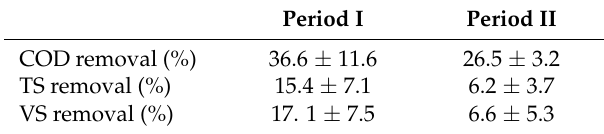
Figure 5. Alkalinity ( × ) and pH ( • ) of manure in reactor during the experiment. The error bars represent the standard deviation of duplicate experiments. Table 5. Average COD, TS, and VS removal efficiencies ( ± standard deviations) during Period I and